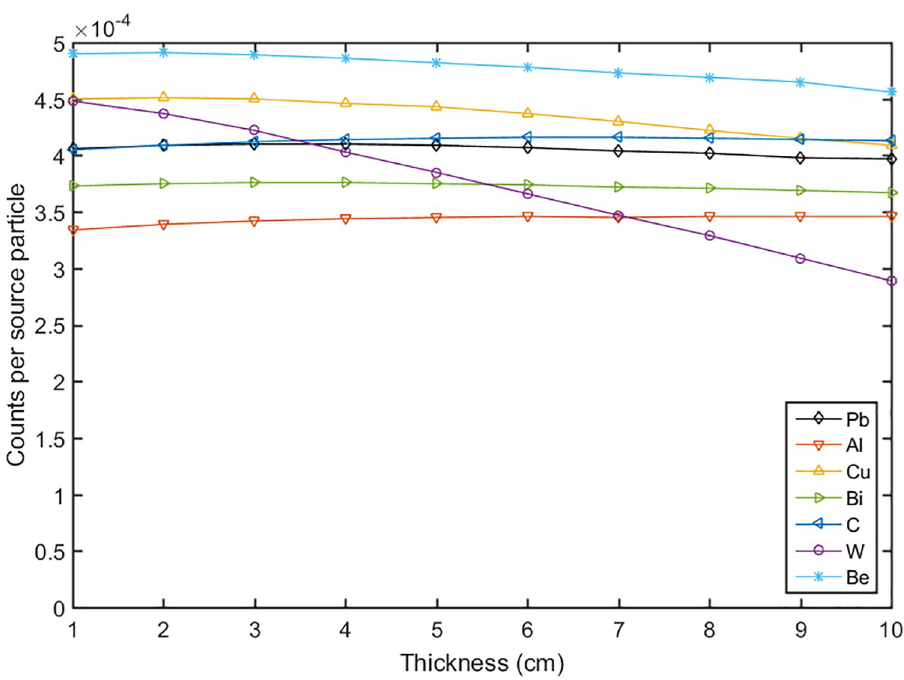
Fig 2. The neutron flux versus the thicknesses of t1 with different materials.